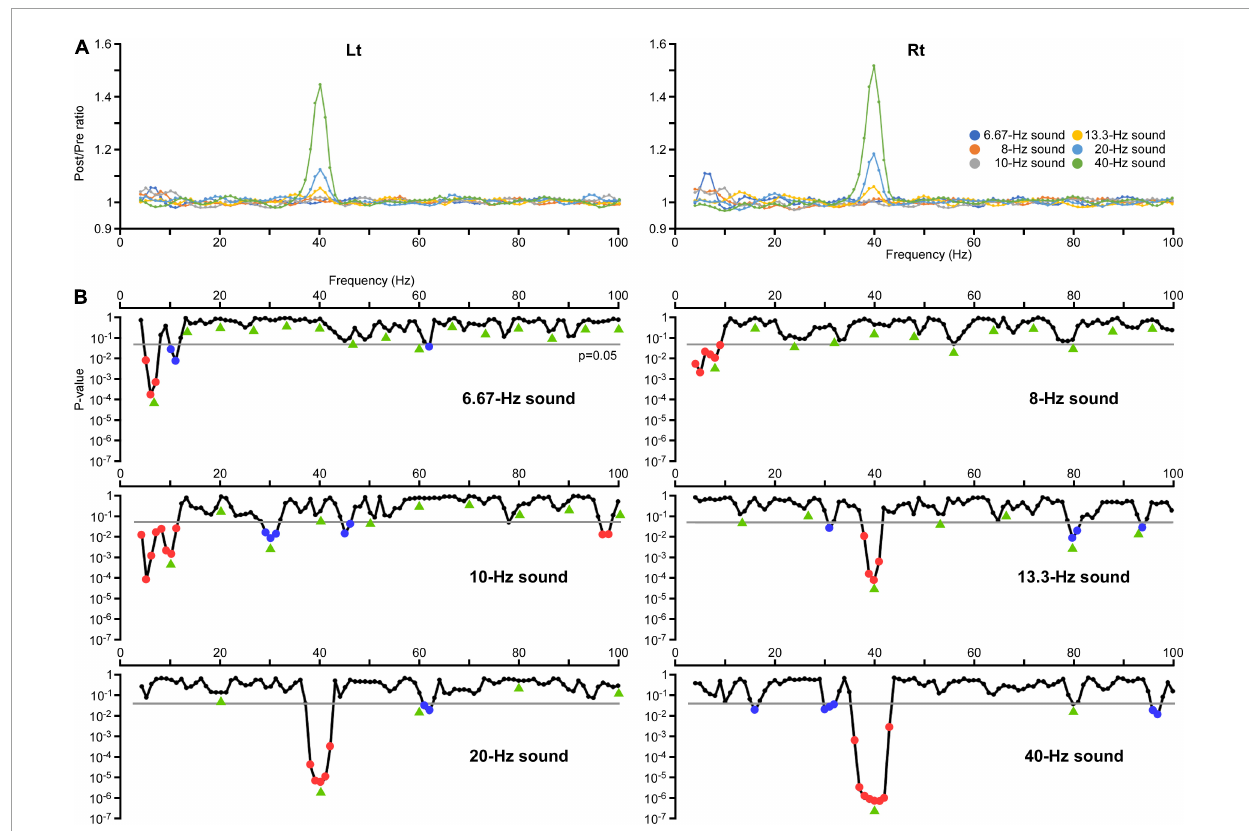
FIGURE1 Changes in the amplitude of oscillations. (A) The effects of modulation of the oscillation on the amplitude at all frequency sampling points. The vertical axis indicates the ratio of the average amplitude at 200–1,000 ms (Post) relative to the baseline from 250 to 0 ms before the onset of auditory stimulation (Pre). (B) The results of two-way ANOVA. The vertical axis indicates the p -values for the effect of PrePost obtained in each condition. Significant increases in the amplitude are indicated by red dots and decreases are indicated by blue dots. Green arrows indicate harmonic frequencies in each